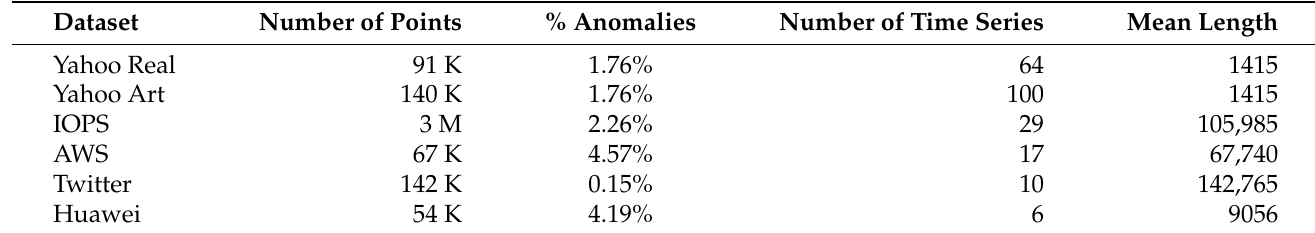
Table 2. Summary statistics for the datasets used in the